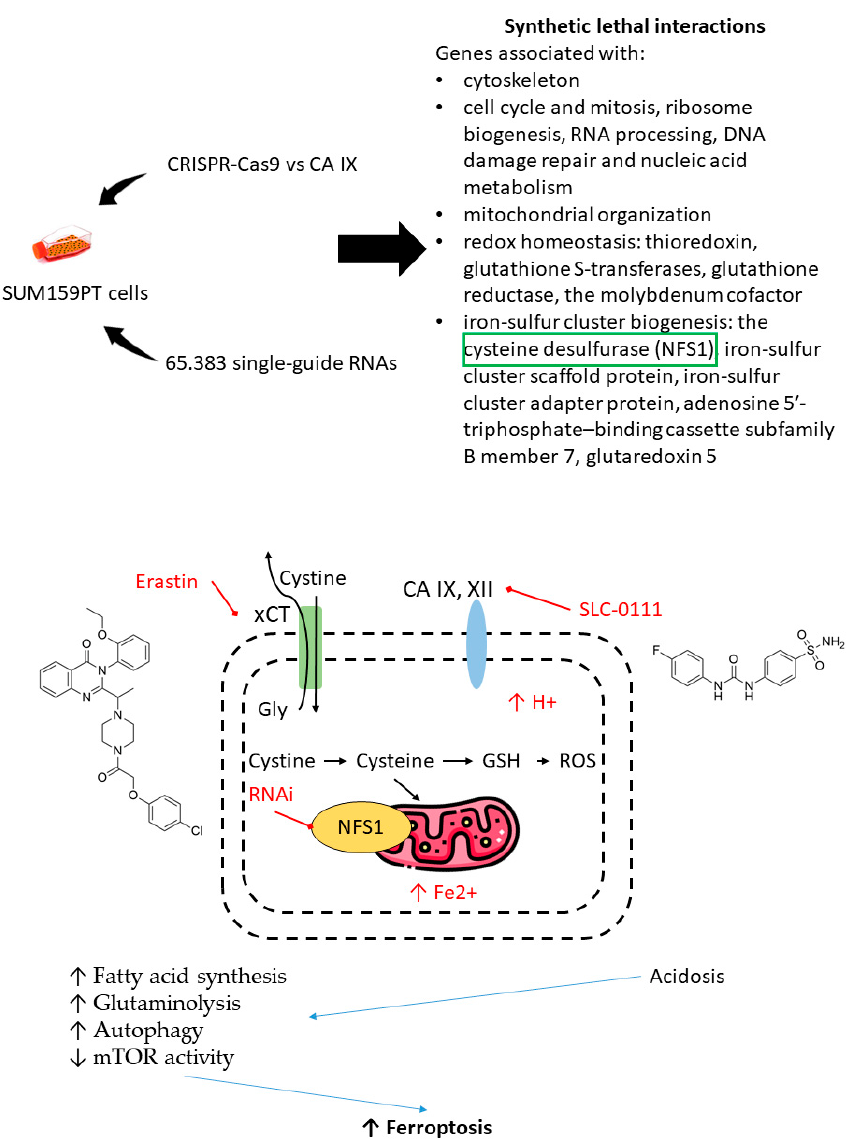
Figure 22. Graphical outline of the study on synthetic lethal gene interactions reported by Chafe et al. [103].